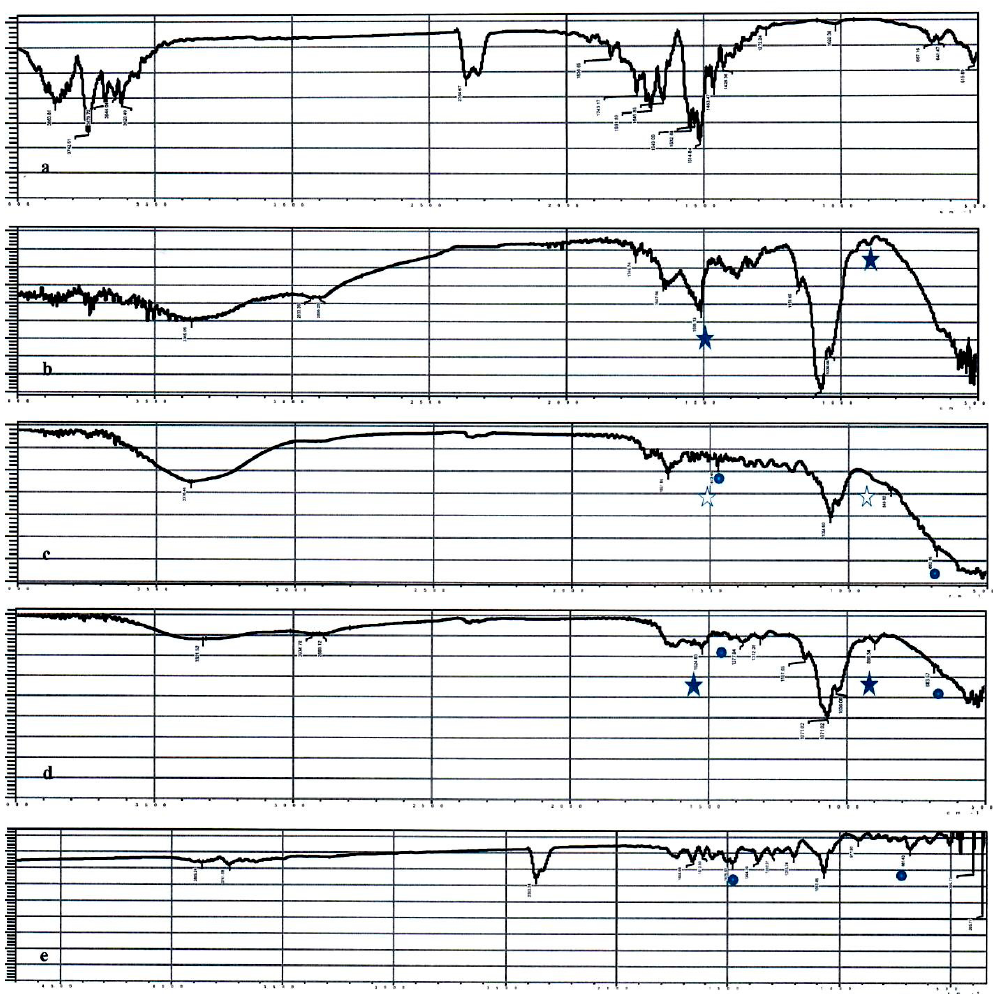
Figure 3. ATR spectra of ( a ) LA; ( b ) CL; ( c ) BA-loaded-LA-modified-CL-NPs; ( d ) BA-loaded-LA-free-CL-NPs and ( e ) BA. The closed stars represent the amine characteristic bands of CL, the open stars represent the absence of the amine characteristic bands of CL and the dots represent the aromatic characteristic bands attributed to the